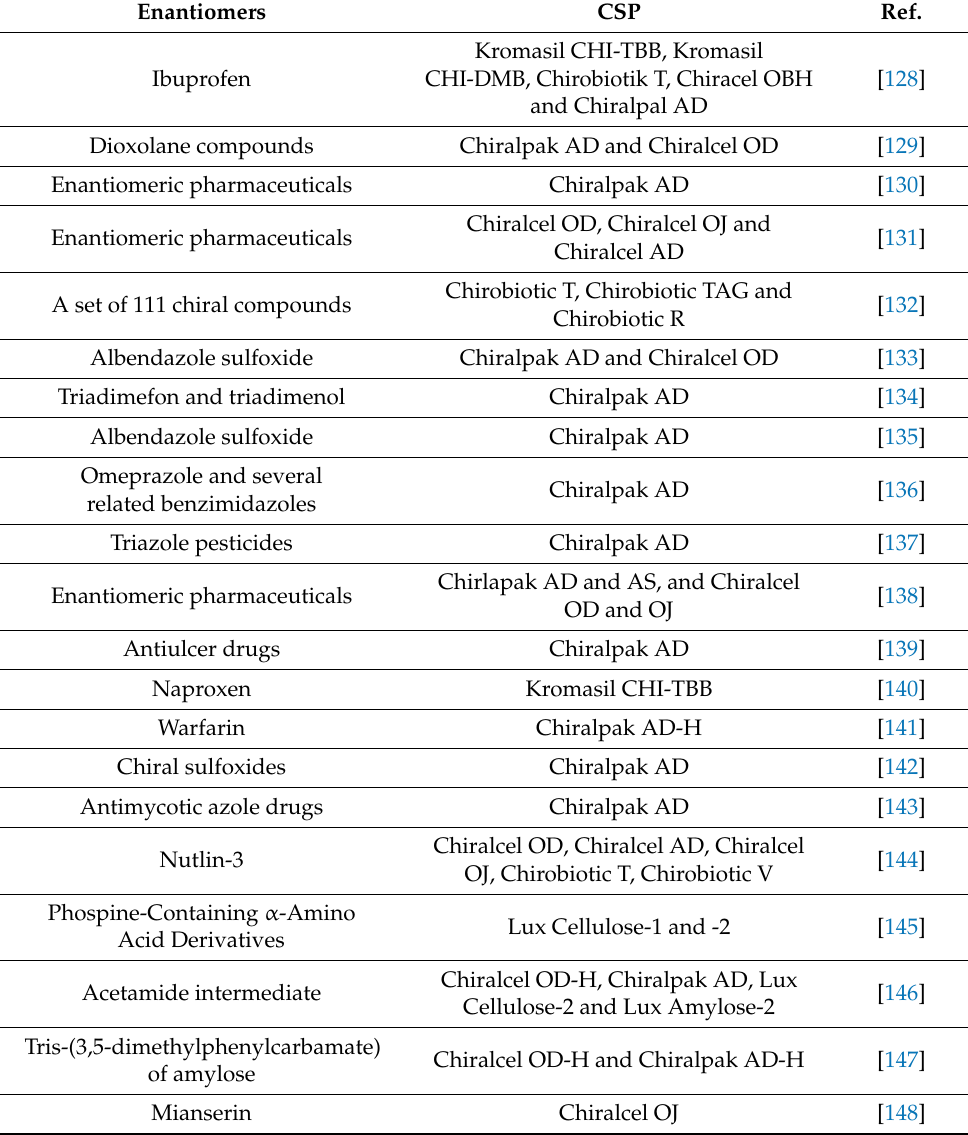
Table 8. Experimental studies of enantioresolutions applying Supercritical Fluid Chromatography.